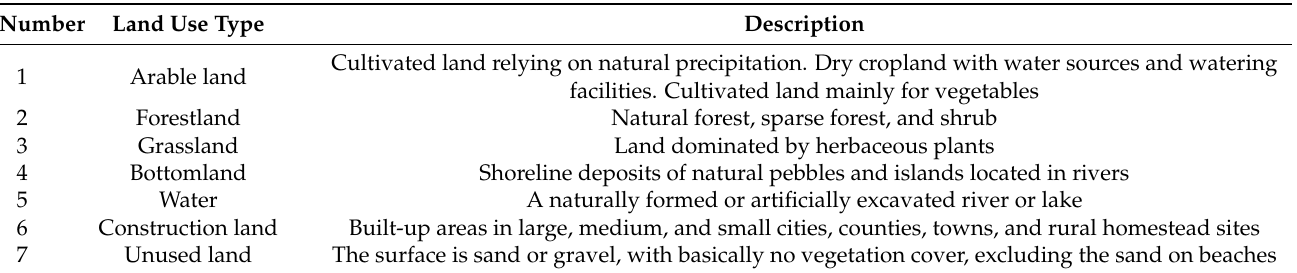
Table 2. Land use classification of the Yongding River floodplain.